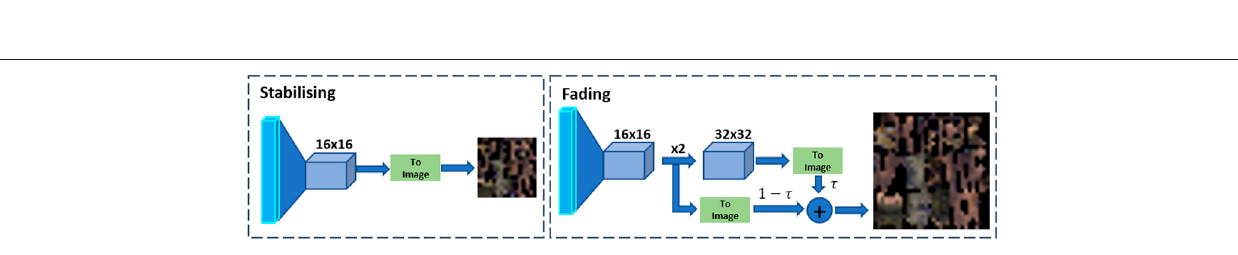
Frontiers in Virtual Reality |